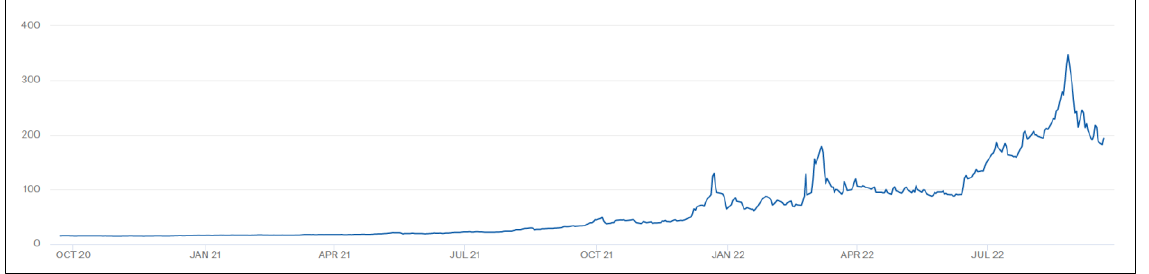
Figure 4. Natural Gas TTF price evolution, adapted from [22] and [26].